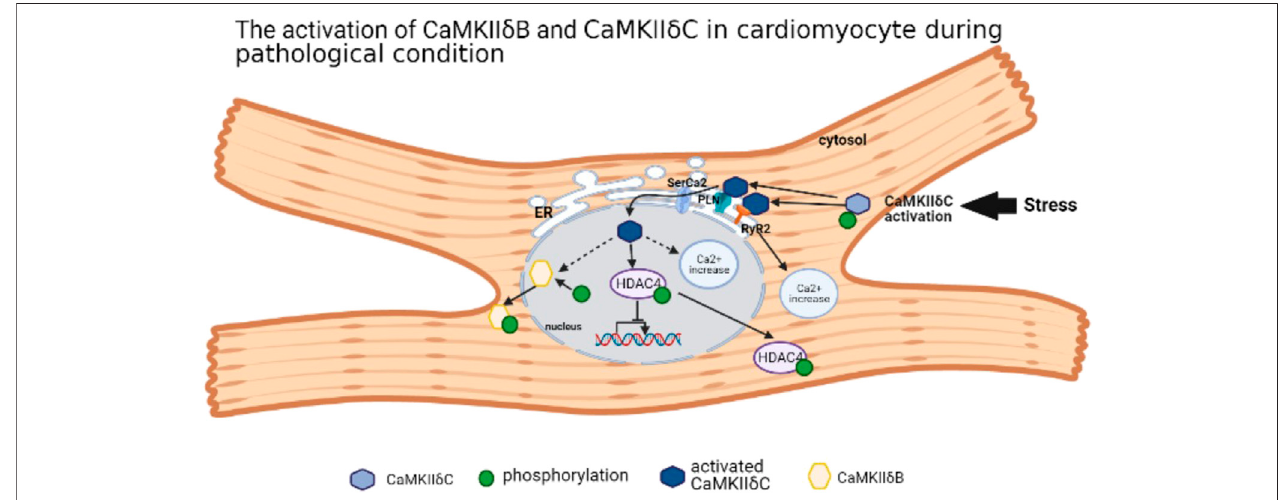
FIGURE 1 | The activation of CaMKII δ B and CaMKII δ C in cardiomyocyte during pathological